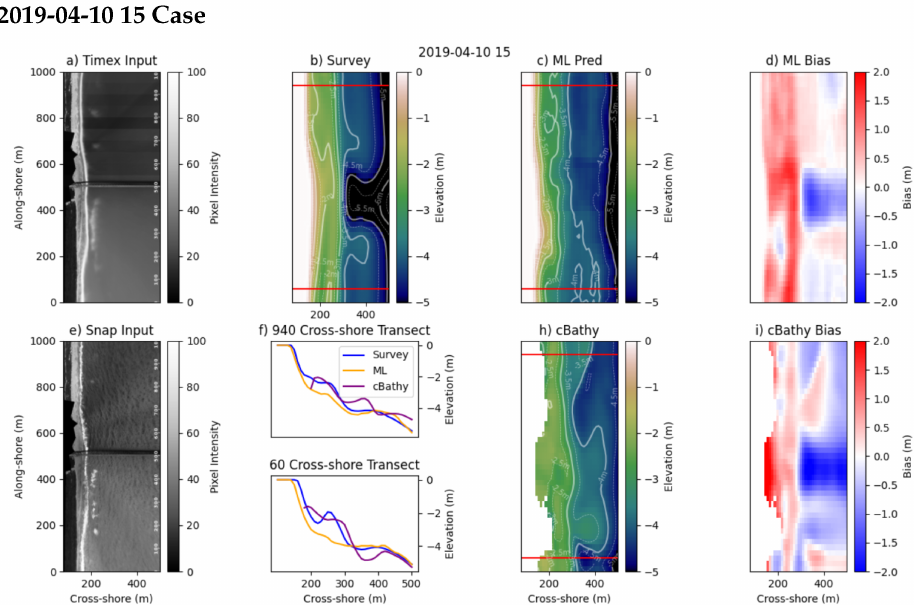
Figure 7. Additional plots evaluating the bathymetry from the third row of Figure 4 and comparing to the cBathy phase 2 output for the same time period. ( a ) shows the Timex image input. ( b ) shows survey-derived bathymetry. ( c ) ML predictions. ( d ) shows the ML depth bias. ( e ) shows the snap image input. ( f ) shows two cross-shore transects at the 60 and 940 along-shore position for the survey and the ML/cBathy methods. ( h ) shows the cBathy prediction, and ( i ) shows the cBathy bias. Wave height (H = 0.57 m), period (T = 4.10 s), wave direction (D =